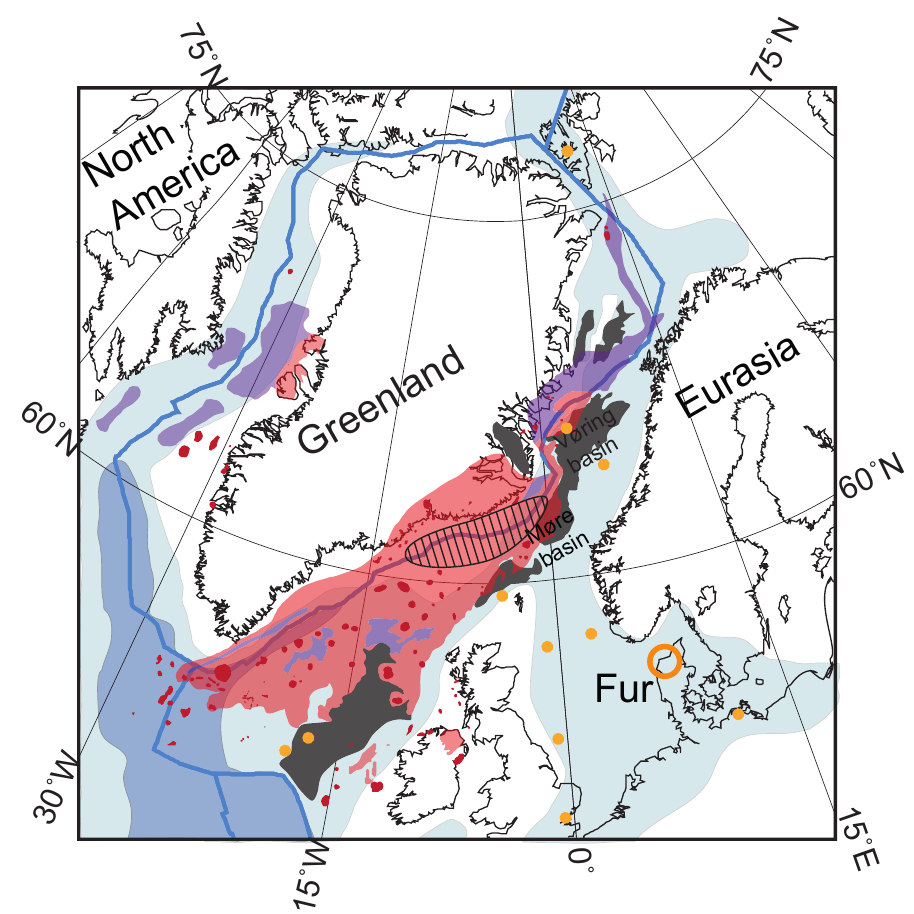
Figure 1: Map of the known extent of the North Atlantic Igneous Province (NAIP) in a regional palaeogeographic reconstruction from 56 Ma. The striped area indicates the most likely source area for the Danish ash layers based on Larsen et al. [2003]. The yellow points show selected known localities of NAIP-derived ash (ash locations from Haaland et al. [2000], Jolley and Widdowson [2005], Morton and Keene [1984], and Morton and Knox [1990]), although NAIP-derived ash is also distributed far outside this map frame such as Goban Spur and in the Austrian Alps [e.g. Egger et al. 2005]. Dark red: volcanic centres. Red areas: the known extent of subaerial and submarine extrusive NAIP volcanism. Purple areas: the known extent of only submarine volcanism. Dark grey areas: known extent of NAIP sill intrusions. Blue lines: plate boundaries. Black lines: present-day coastlines. Light blue: shelf areas. Dark blue: ocean basins. Figure modified from Abdelmalak et al. [2016]; Á Horni et al. [2017]; Jones et al. [2019], and references